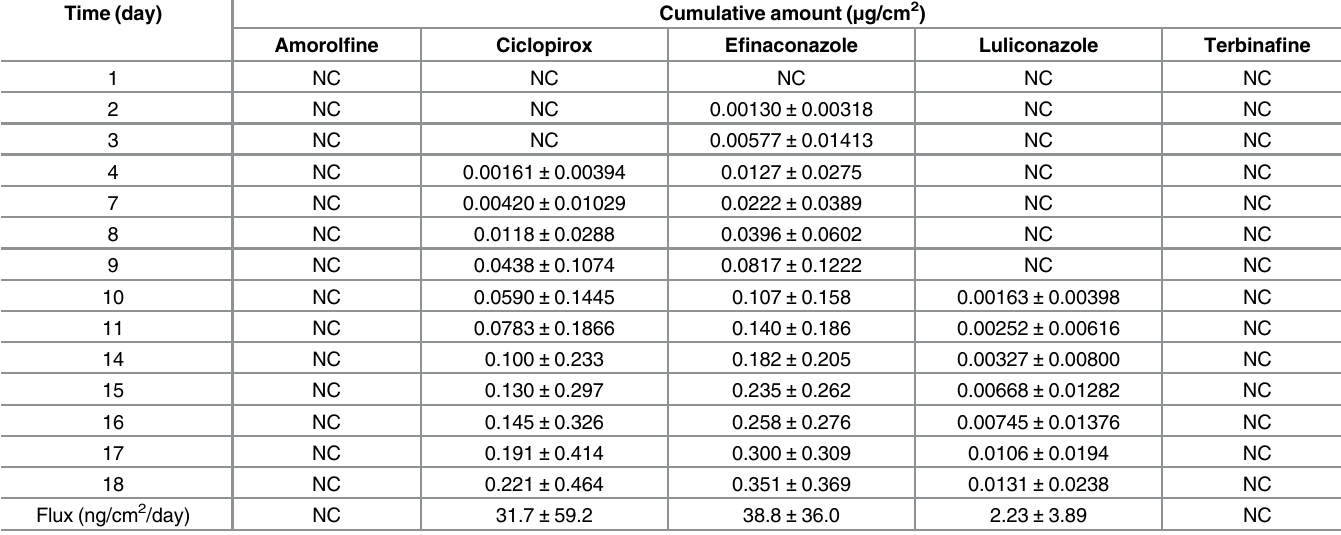
Table 2. Cumulative drug amount permeated after a single application of five test drugs to human nails.